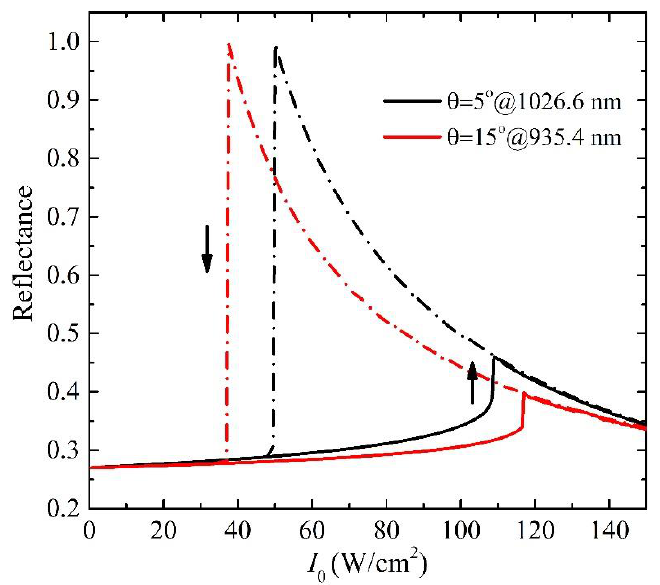
Figure 4. The hysteresis loops of the reflectance in the GMR nanostructures at θ = 5° and 15° with the working wavelength 1026.6 nm and 935.4 nm,